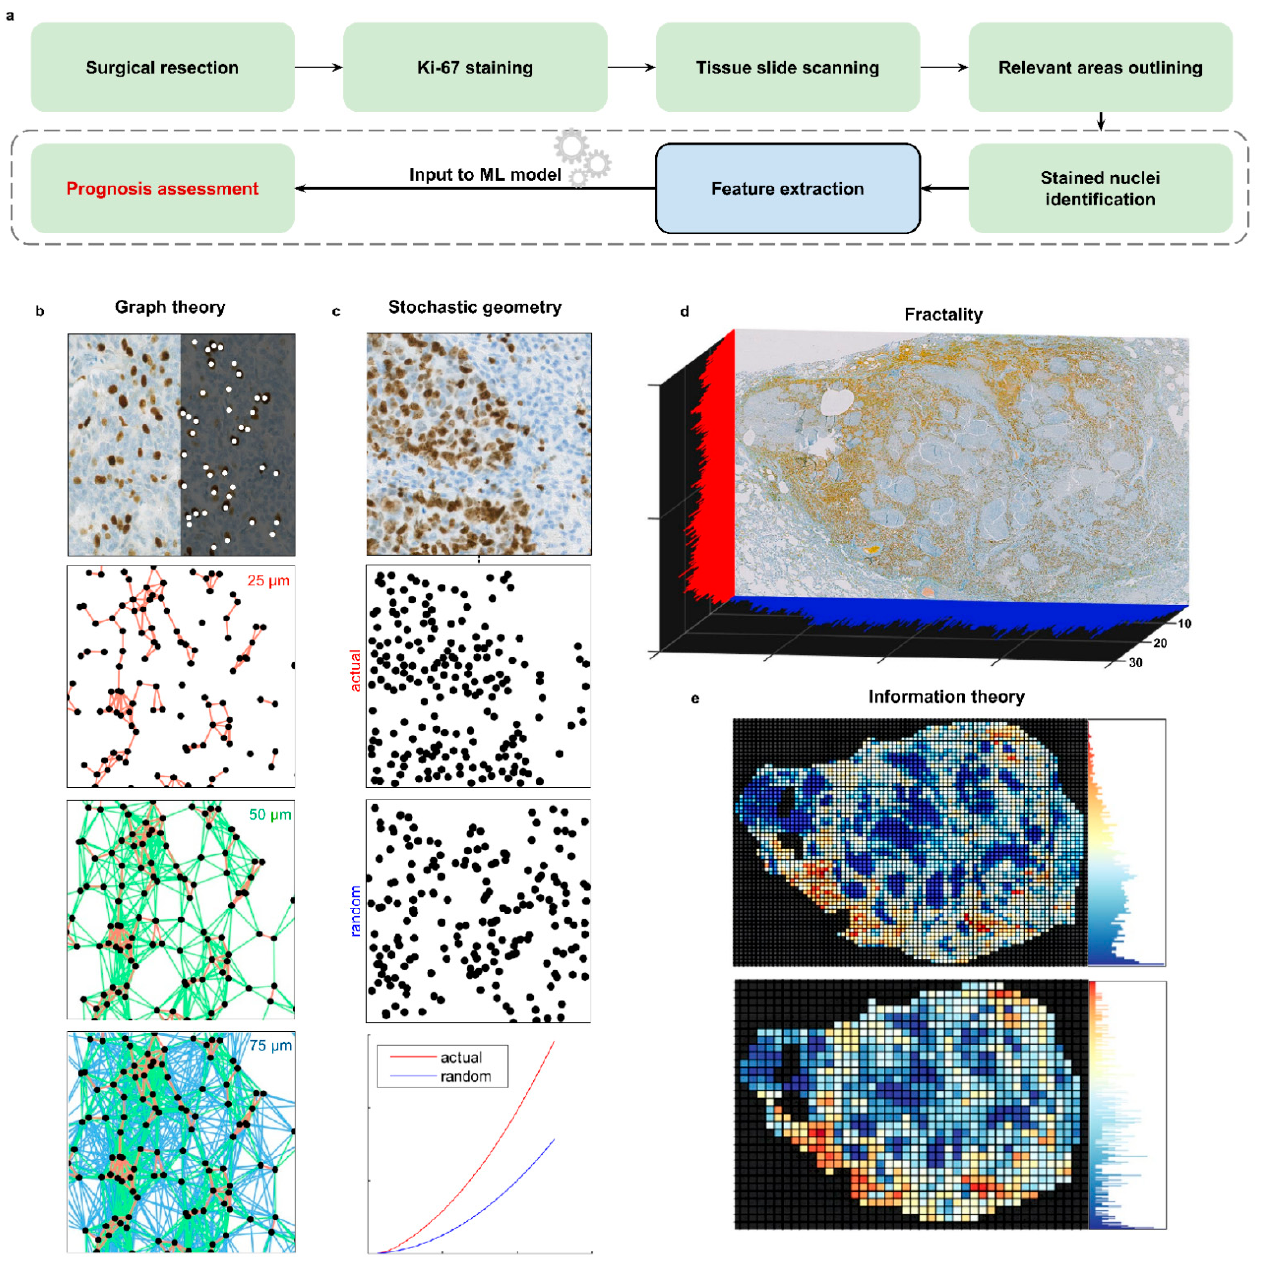
Figure 1. ( a ) Schematic of the steps of our prognosis assessment framework, from input to output. The lower half blocks represent the core procedures carried out by our software implementation. ( b – e ) Presentation of the categories of features extracted by our system. ( b ) Graph theory features rely on the construction of graphs from Ki-67+ cells, considering each cell as a node and connecting two nodes if their mutual distance is lower than a fixed proximity threshold. ( c ) Ki-67 + cells are interpreted as a stochastic point process; features are derived by measuring how distant the cell spatial arrangement is from a truly random one. ( d ) Visual representation of the preliminary process for evaluating Higuchi’s fractal dimensions of a sample. For each row and column of pixels of the image, the number of Ki-67 + cells present on that line is counted, and the existence of fractal patterns is then evaluated on the obtained distributions, shown in red and blue in the figure. The measure presented on the axis is exactly the number of Ki-67 + cells found on that pixel row or column. ( e ) Shannon’s entropy of the Ki-67 + cell distribution. This measure is evaluated by dividing the image in squared sub-regions, counting the number of replicating cells lying inside each window and evaluating the skewness of the corresponding value distribution. This feature is computed for different sub ‐ region sizes, as exemplified in the panel.